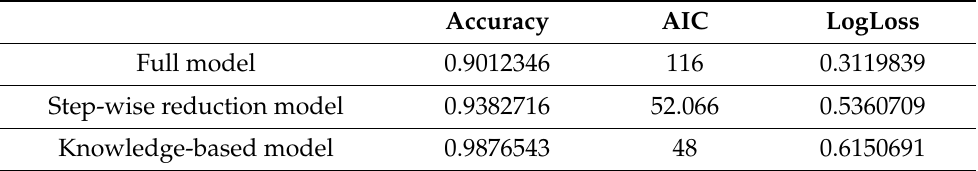
Table 2. Performance measures to compare the three